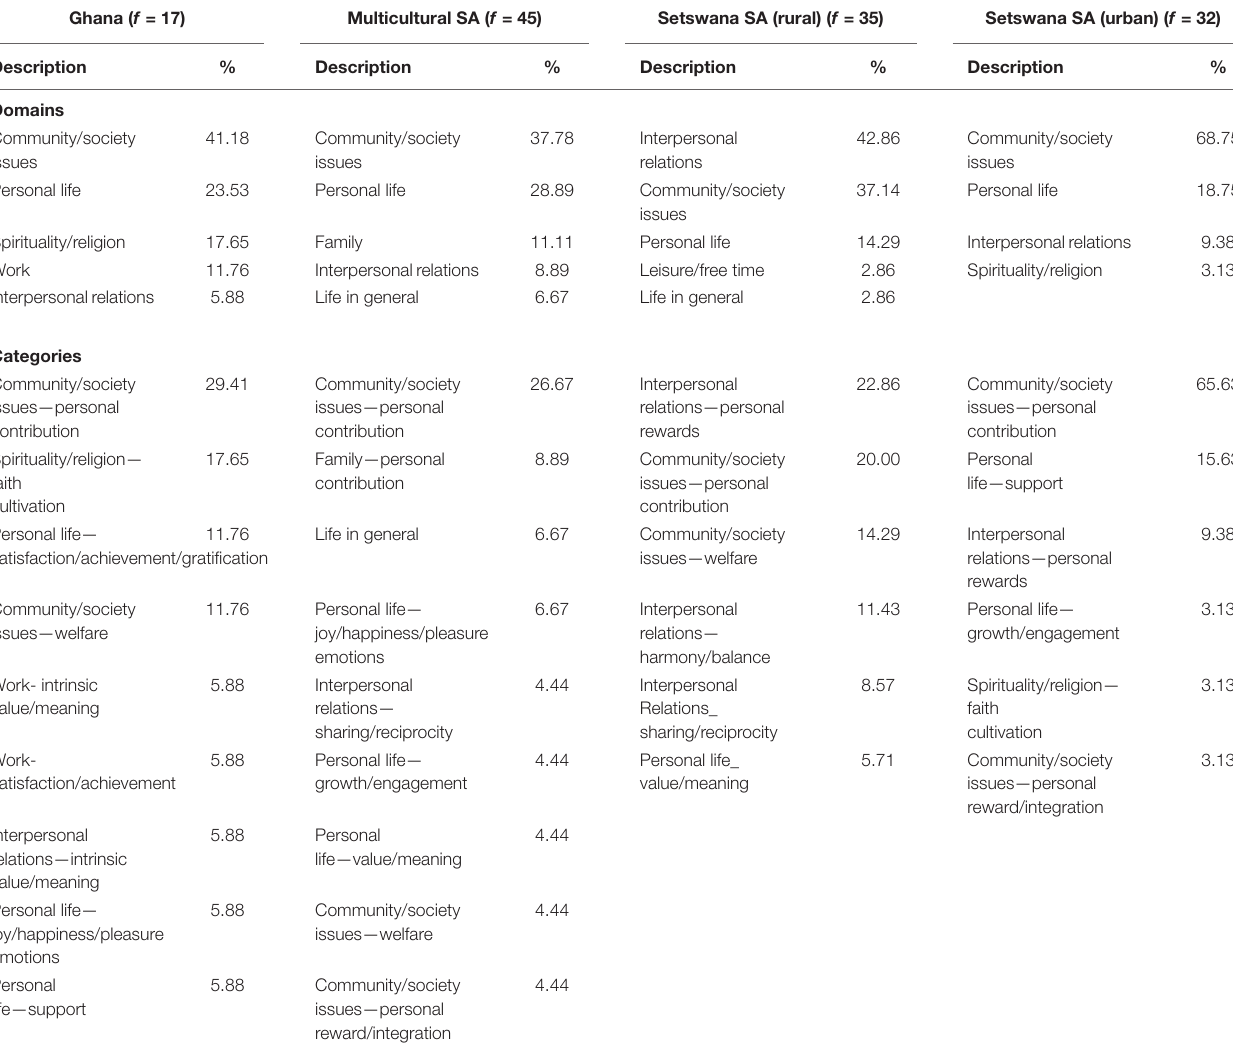
TABLE 9 | Percentages of the most frequent domains and categories in the motivations for meaning sources in the community/society domain of life. Ghana ( f = 17) Multicultural SA ( f = 45) Setswana SA (rural) ( f = 35) Setswana SA (urban) ( f =